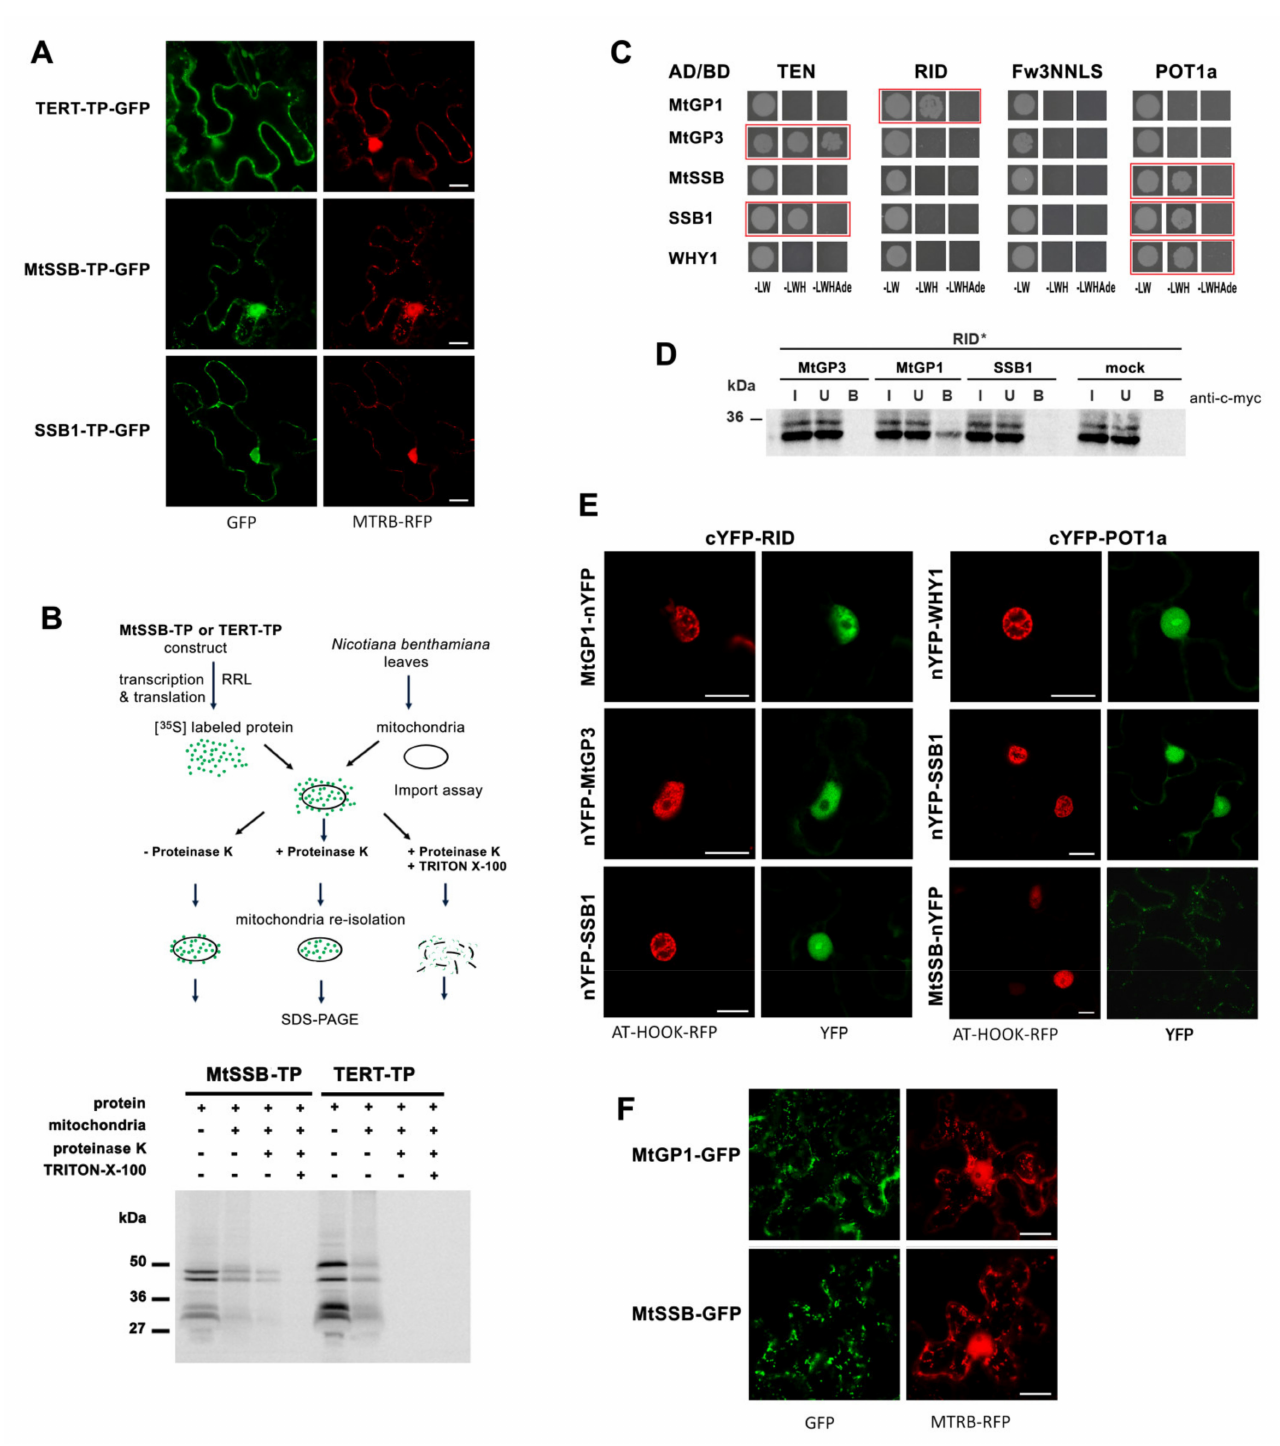
Figure 4. Investigation of AtTERT mitochondrial targeting and interactions with putative organelar- targeting proteins. ( A ) Construct bearing putative transit peptide (TP) sequence of AtTERT fused with the GFP tag showed similar localization when compared with the TP constructs of MtSSB, SSB1 proteins and with the mitochondrial marker MTRB-RFP in transiently transfected N. benthamiana leaves. Note that the MTRB-RFP marker [51] has apparently labelled plant mitochondria and nuclei. ( B ) Mitochondrial import assays show that AtTERT-TP and MtSSB-TP constructs co-purified with mitochondria but that TERT-TP was not imported into mitochondria. Radioactively labelled